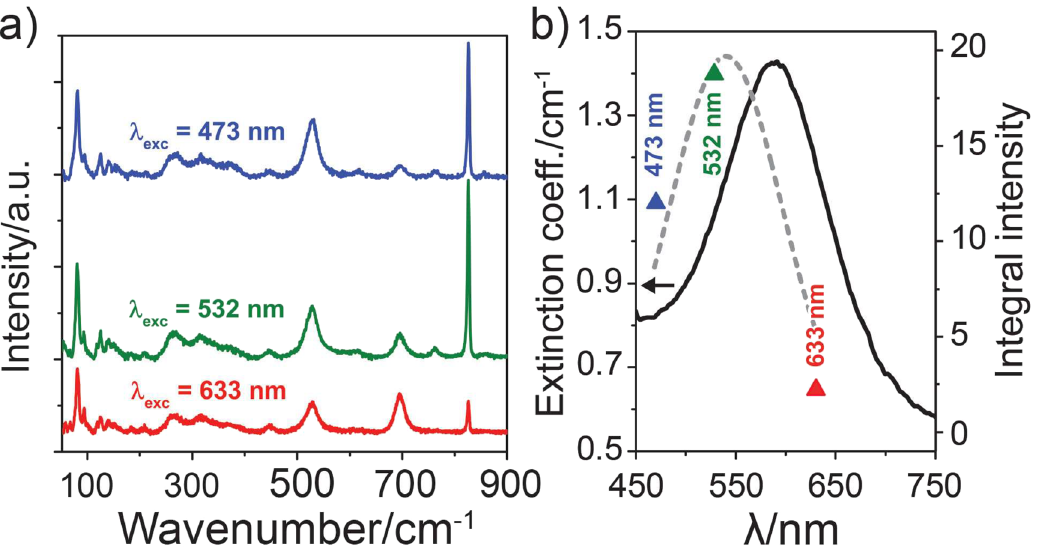
Figure2: LSPRastheoriginoftheRamanenhancementintheBi 2 O 3 -Agcomposite.(a)RamanspectrafromtheprecipitatescontainingAgand γ -Bi 2 O 3 nanocrystals, collected with three excitation wavelengths, 473, 532 and 633 nm. (b) Excitation pro 826 cm − 1 Raman bands (triangles) obtained with different excitation wavelengths, compared with the LSPR peak in the extinction spectrum (solid black line). The grey dashed line presents the Gaussian fi t to the excitationpro fi le. The relationship betweenthe intensities of the LSPR and the investigated Raman band is consistent with the plasmonic resonant origin of the Raman band